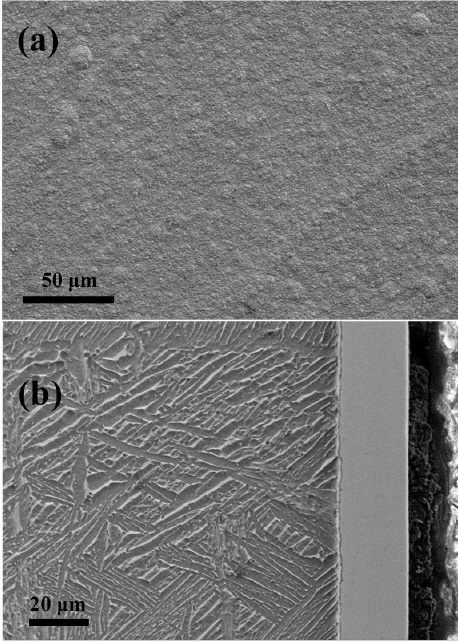
Figure 2. ( a ) Plan view and ( b ) cross-sectional SEM morphologies of the Ta 2 N coating.